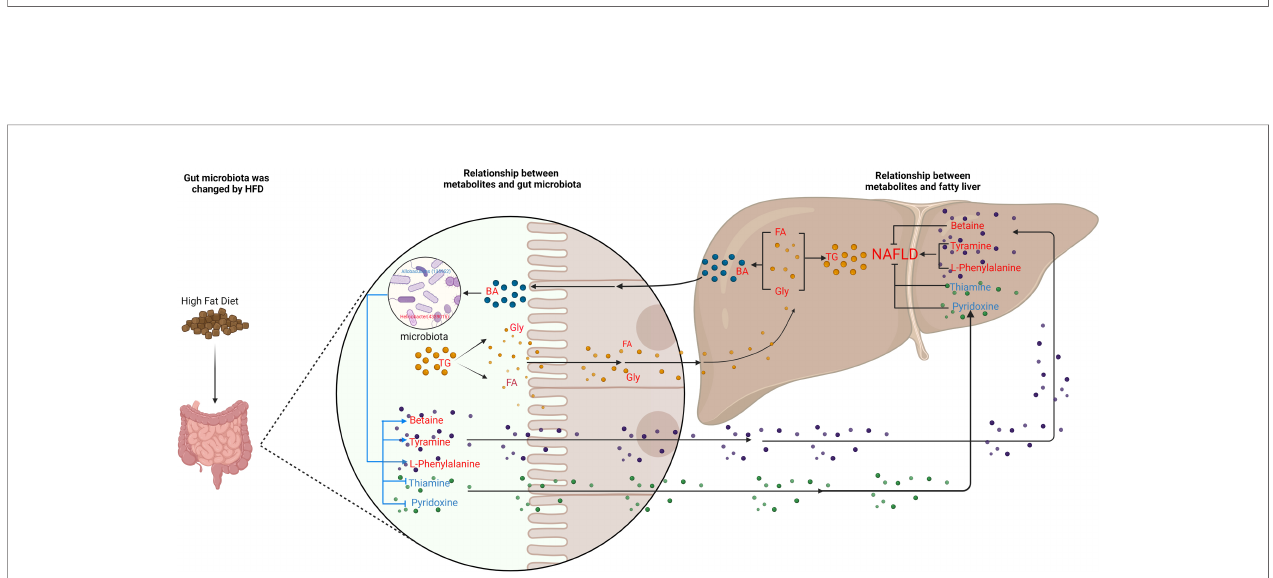
FIGURE 10 | Schematic fi gure illustrating the relationship between gut microbiota and metabolites, and its effect on NAFLD. Red font represent up-regulated metabolites; blue font represent down-regulated metabolites. The blue line represents the pathways studied in this experiment, and the black line represents the pathways supported by the